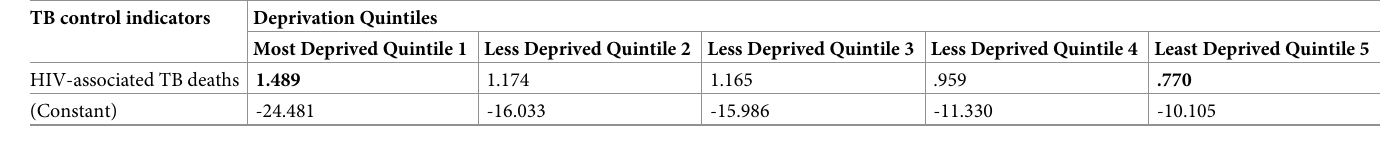
Table 8. Classification of function coefficients during a canonical discrimination